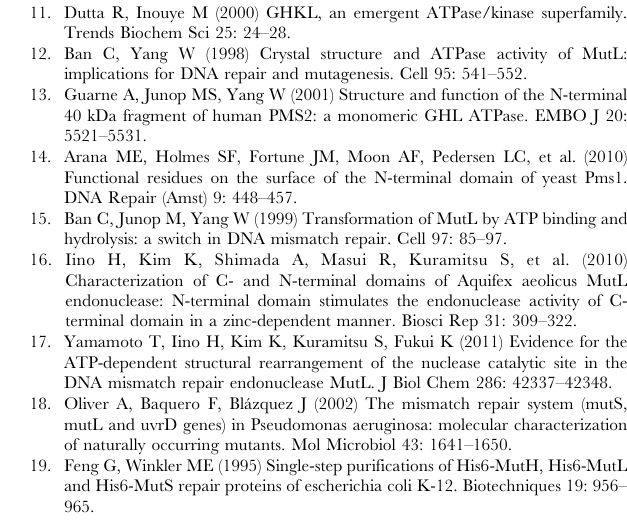
Figure S5 Oligomeric state of EcNTD. Crosslinking analysis (DSS 2.5 mM) of the EcNTD oligomeric state incubated ON in absence (EDTA incubated) or in presence of ADP, ATP or AMPPNP (lanes 3–6) were performed. Lane 1: molecular weight markers; Lane 2: control with no DSS. (TIF) Figure S6 paNTD putative DNA binding site. DNAbindR [44] server was used to predict PaNTD residues involved in DNA binding. (A) The alignment of Subdomain II (SBII) of PaNTD and EcNTD sequences is shown, along with the residues predicted with DNAbindR to be involved in DNA contact ( # ). Secondary structure of EcNTD residues involved in binding are represented. The nomenclature used corresponds to the one used in LN40 crystal structure (PDB: 1B63). PASBII: PaNTD sub-domain II sequence. ECSBII: EcNTD sub-domain II sequence. The predicted PaNTD DNA binding residues are shown in red in the 3D model of the PaNTD dimer from a front (B) and bottom view (C). The figure was generated using VMD [39]. (TIF) Figure S7 Analysis of PaNTD-PaCTD interaction using far Western assays. Purified PaCTD with no-tag (1) BSA (negative control) (2) andHis6-PaNTD (20 pmol) as a positive control (3) were spotted onto nitrocellulose membranes. The membranes were incubated with His6-PaNTD with buffer, buffer plus ADP 0.1 mM or ATP 0.1 mM followed by immunochemical detection of His6-PaNTD as described in Material and methods.